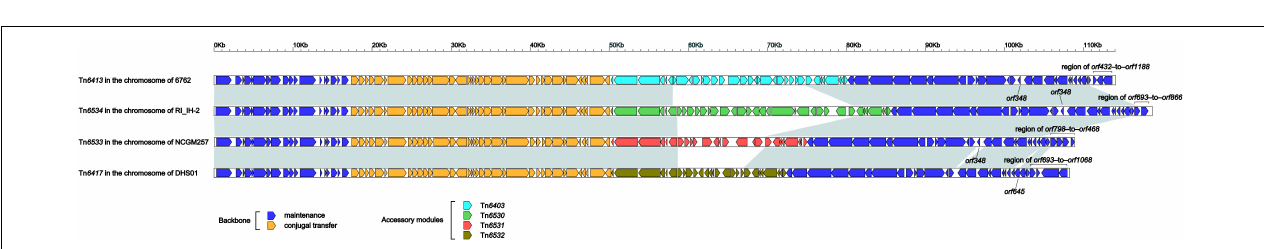
FIGURE 5 | Linear comparison of Tn 6413 with related ICEs. A linear comparison is carried out for DNA sequences of Tn 6413 (this study), Tn 6534 (accession number KX196168), Tn 6533 (accession number AP014651), and Tn 6417 (accession number CP013993). Genes are denoted by arrows. Genes, mobile elements and other features are colored based on function classification. Shading denotes regions of homology ( > 95% nucleotide identity).